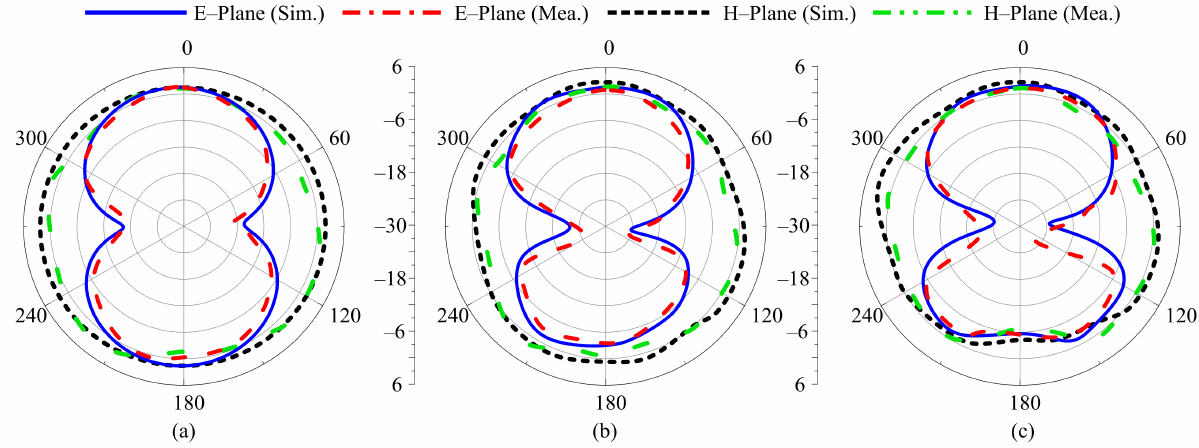
Figure 16. Simulated and measured radiation pattern of proposed antenna at 1.8 GHz for Case-111.